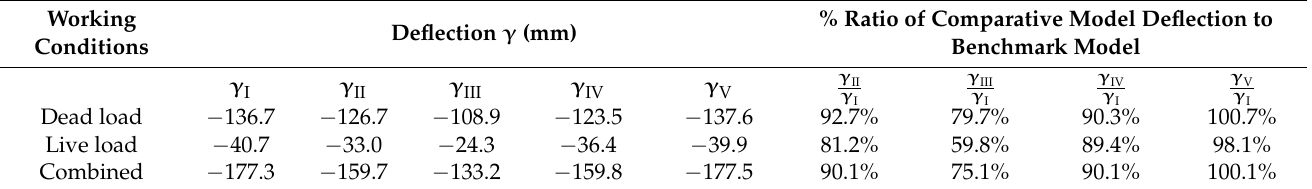
Table 2. Mid-span deflections of box girder under different working